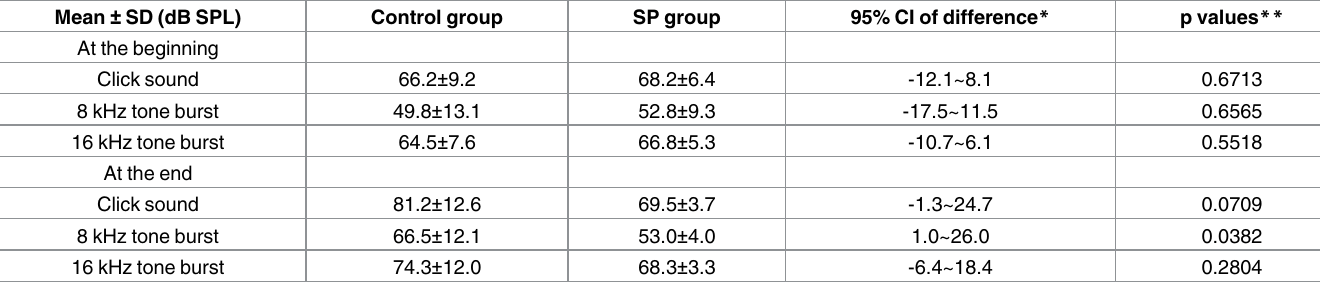
Table 1. ABR thresholds of the both groups at the beginning and the end of this study. Mean ± SD (dB